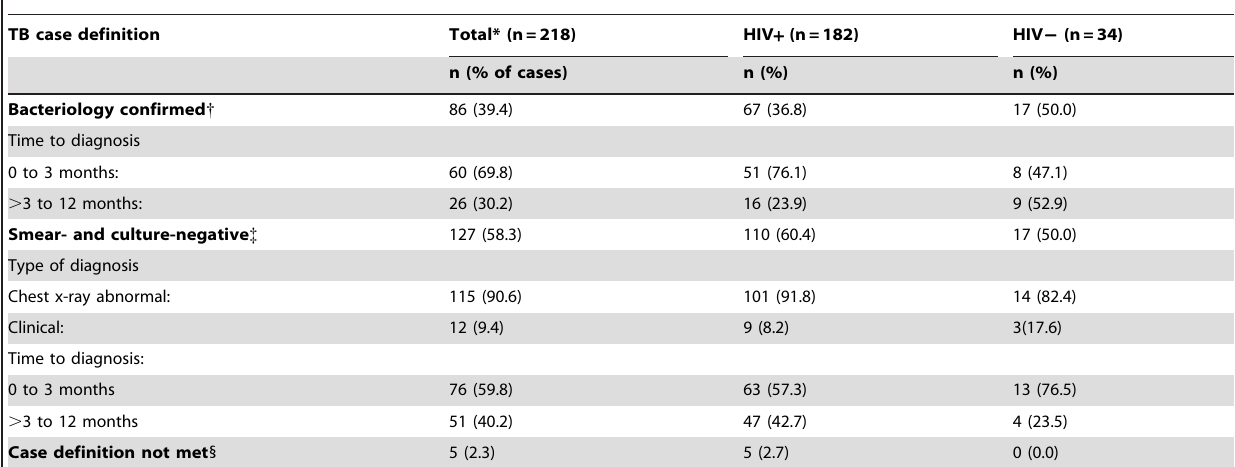
Table 2. TB cases diagnosed during study period.